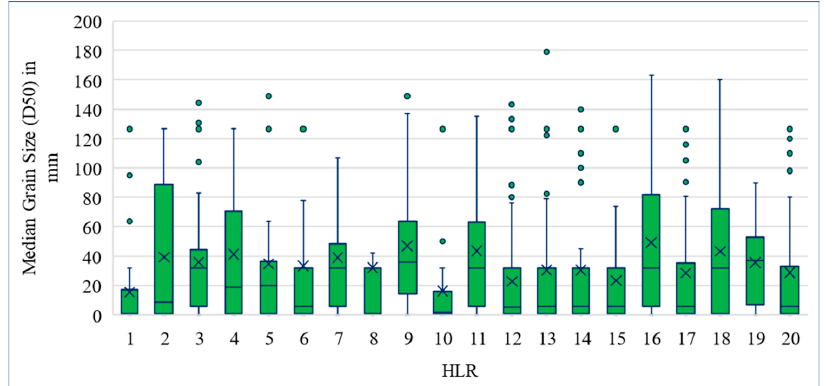
Figure 8. Box Plot showing the range of D50 data over Hydrologic Landscape Regions of the U.S. Boxes indicate data range falling between the first and third quartile. Note: Horizontal lines within the boxes indicate median values whereas the ‘X’ sign designates averages.